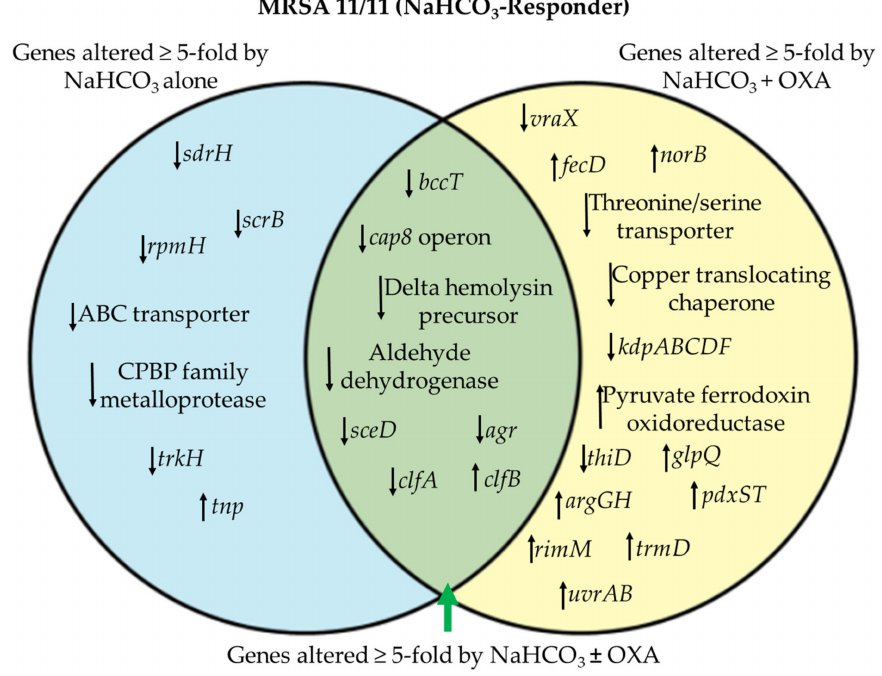
Figure 2. Venn diagram of genes altered ≥ 5-fold by NaHCO 3 exposure without (left) or with (right) OXA exposure specifically in NaHCO 3 -responsive strain MRSA 11/11. Arrows indicate whether expression was decreased (downward arrow) or increased (upward arrow) by NaHCO 3